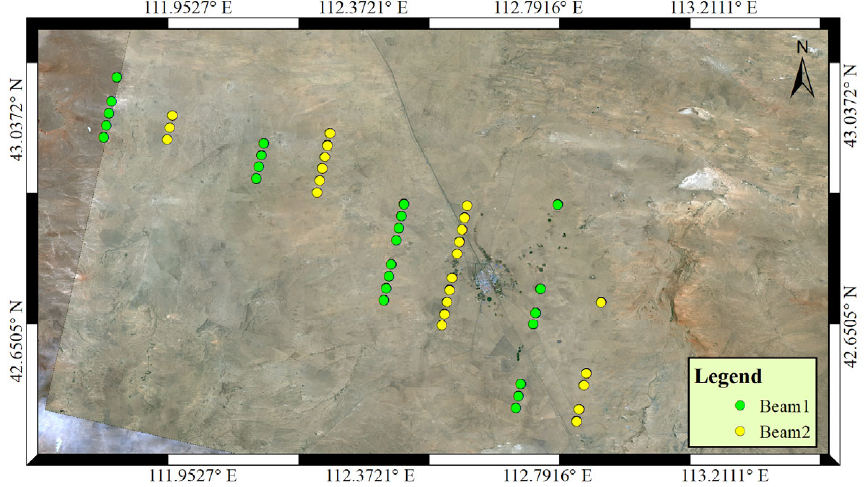
Figure 2. Elevation accuracy verification area and data points from the GF ‐ 7 satellite laser.